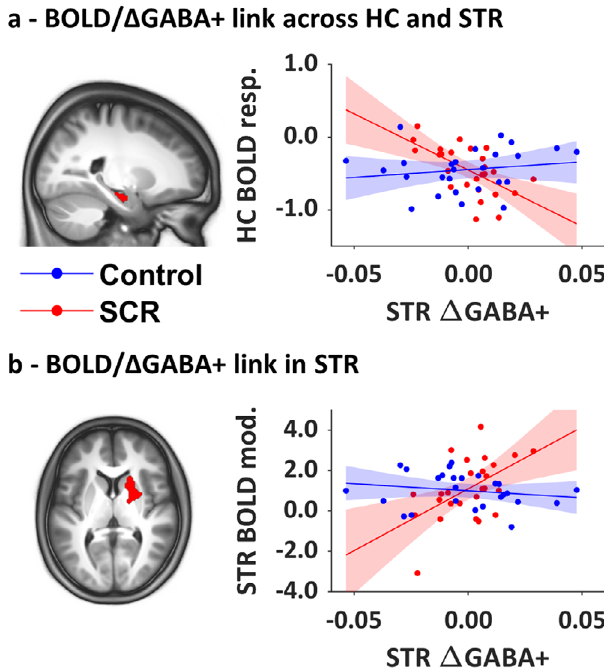
Fig. 7 Correlations between task-related BOLD responses during MSL and striatal (STR) Δ GABA + . For display purposes, activation maps are overlaid on a T1-weighted template image with a threshold of p < 0.005 uncorrected. Regression plots represent BOLD responses (resp.) [practice > rest] ( a ) or magnitude of practice-related modulation (mod.) in BOLD responses ( b ) against STR Δ GABA + for the two groups. a Link between Δ GABA + and BOLD across regions: brain responses in the left HC [ − 20 − 14 − 20 mm] were differently correlated with changes in STR GABA + ( Δ GABA + ; i.e., post minus baseline) in the SCR and control groups. b Link between Δ GABA + and BOLD within the STR: dynamical brain responses in the right putamen [20 14 6 mm] were differently correlated with Δ GABA + in the SCR and control groups. A positive BOLD modulation value re fl ects an increase in activation over learning. Regressions with STR Δ GABA + : N Control = 26, N SCR = 26. BOLD and GABA measures are in arbitrary